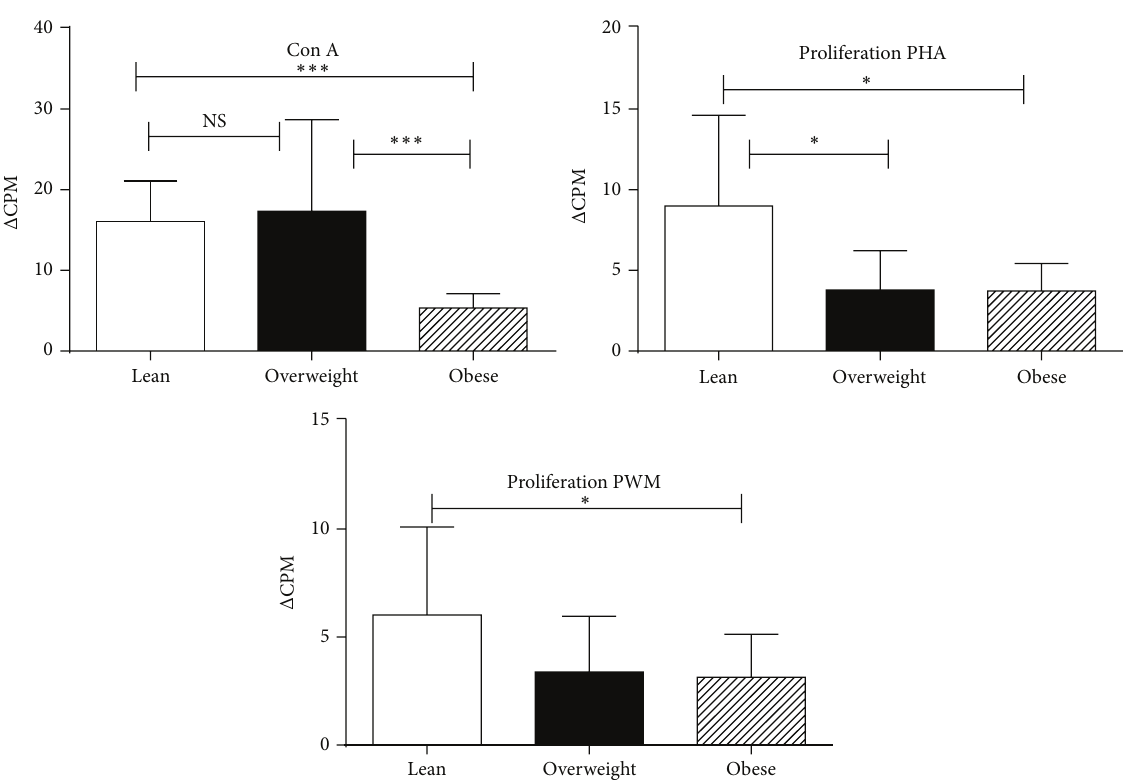
Figure 3: Proliferative response of PBMCs to mitogens in lean, overweight, and obese chimpanzees. PBMCs isolated from the blood samples of the chimpanzees were used for determining proliferative response in triplicate wells using the standard [ 3 H] thymidine incorporation assay. The proliferation responses are expressed as delta ( Δ ) count per minuets (CPM). Δ value representing increase in radioactivity incorporated in presence of the mitogen over to that in medium control. The results shown are average of three distinct experiments and comparison between groups of chimpanzees was done by one-way analysis of variance with the Kruskal-Wallis test as described in Figure